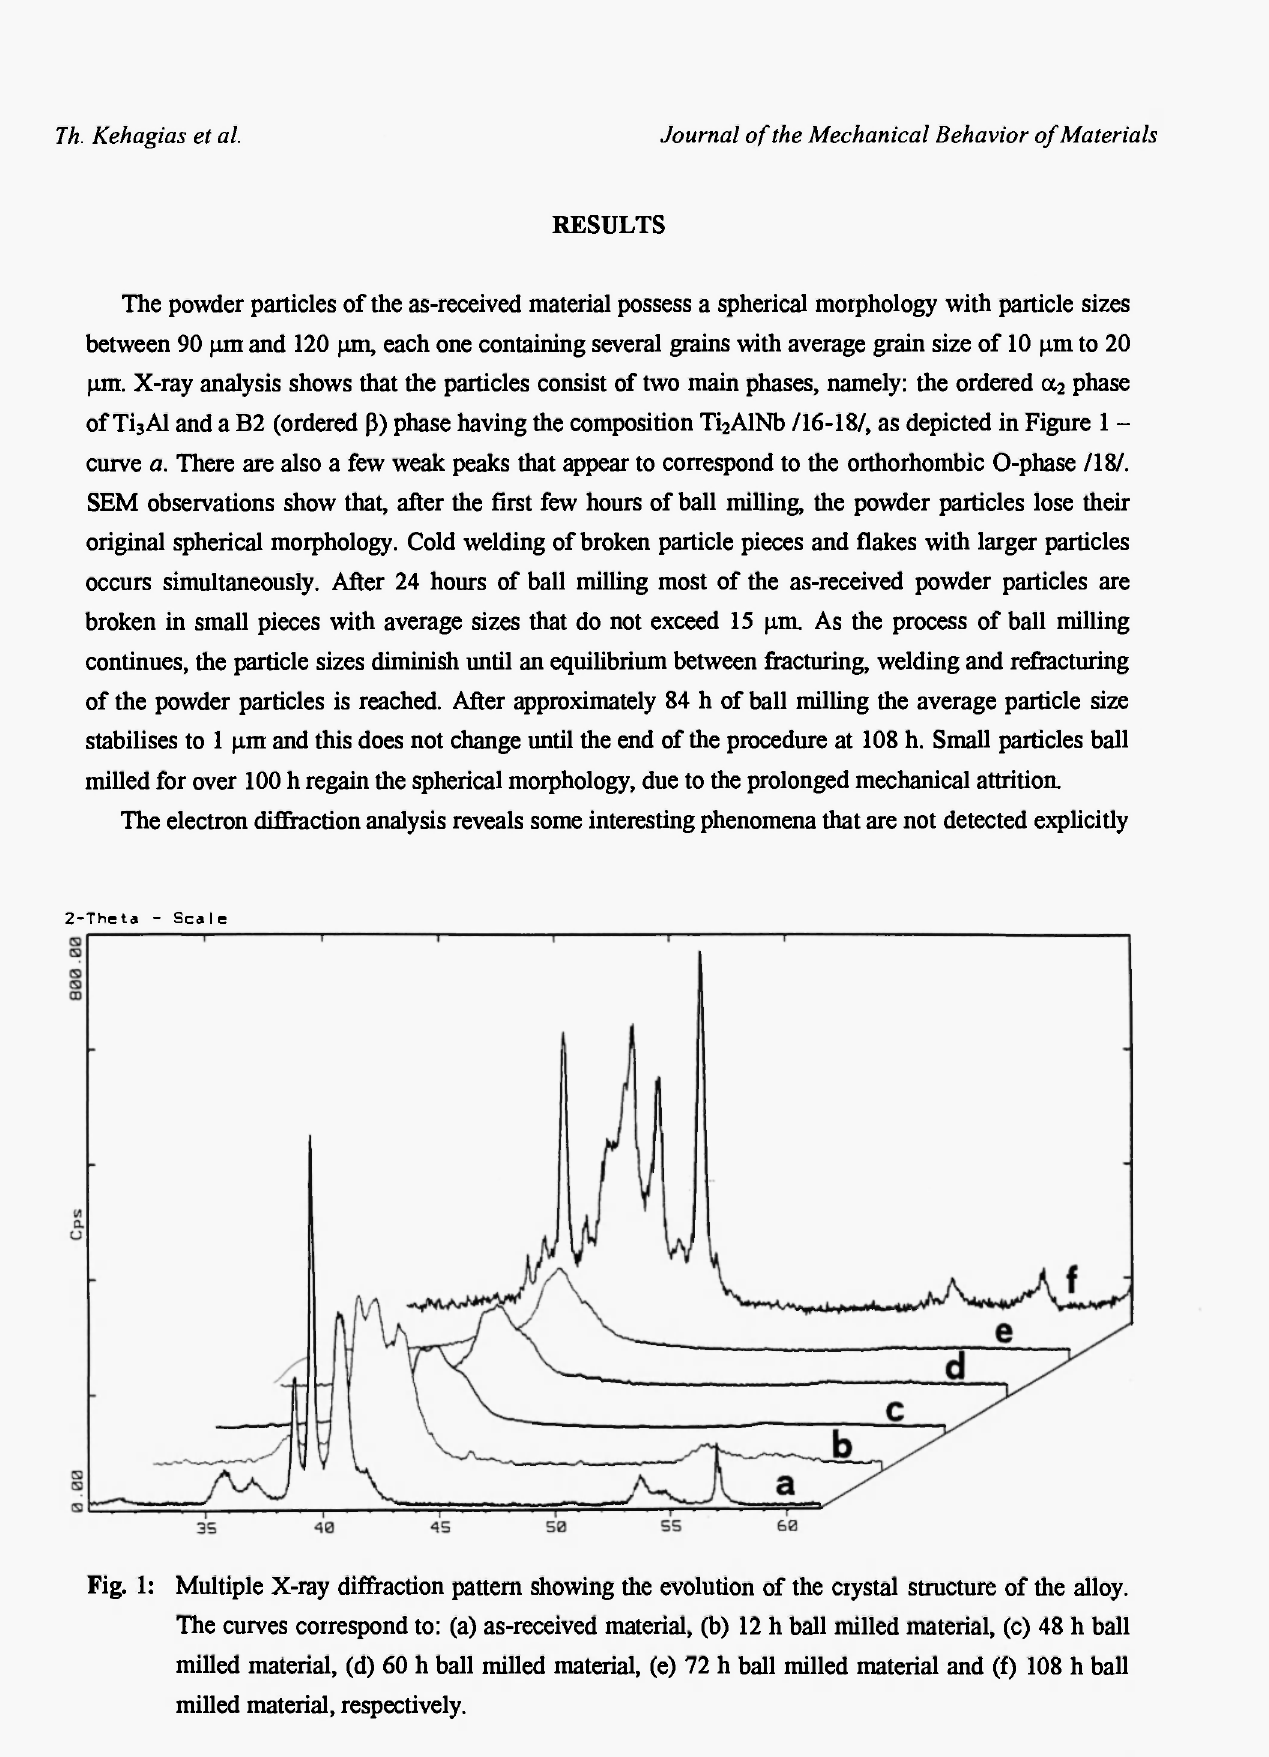
Fig. 1: Multiple X-ray diffraction pattern showing the evolution of the crystal structure of the alloy. The curves correspond to: (a) as-received material, (b) 12 h ball milled material, (c) 48 h ball milled material, (d) 60 h ball milled material, (e) 72 h ball milled material and (f) 108 h ball milled material,